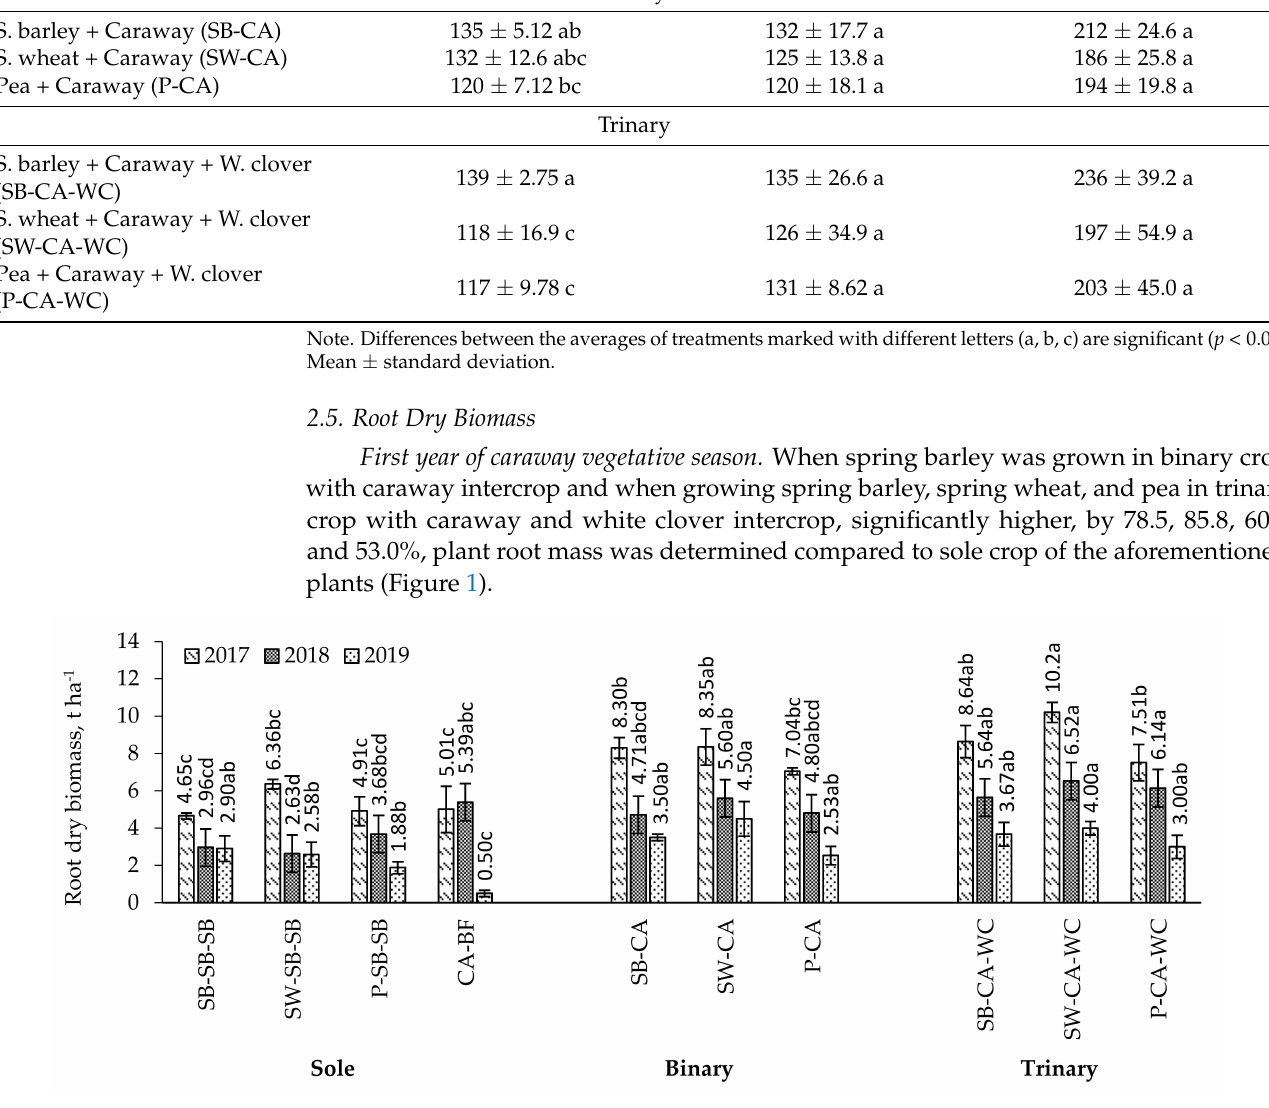
Figure 1. Root dry biomass in sole, binary, and trinary crops in 2017–2019. Note. CA—caraway; SB—spring barley; SW—spring wheat; P—pea; WC—white clover; BF—bare fallow. Differences between the averages of treatments marked with different letters (a, b, c, d) are significant ( p < 0.05); error bars indicate the standard